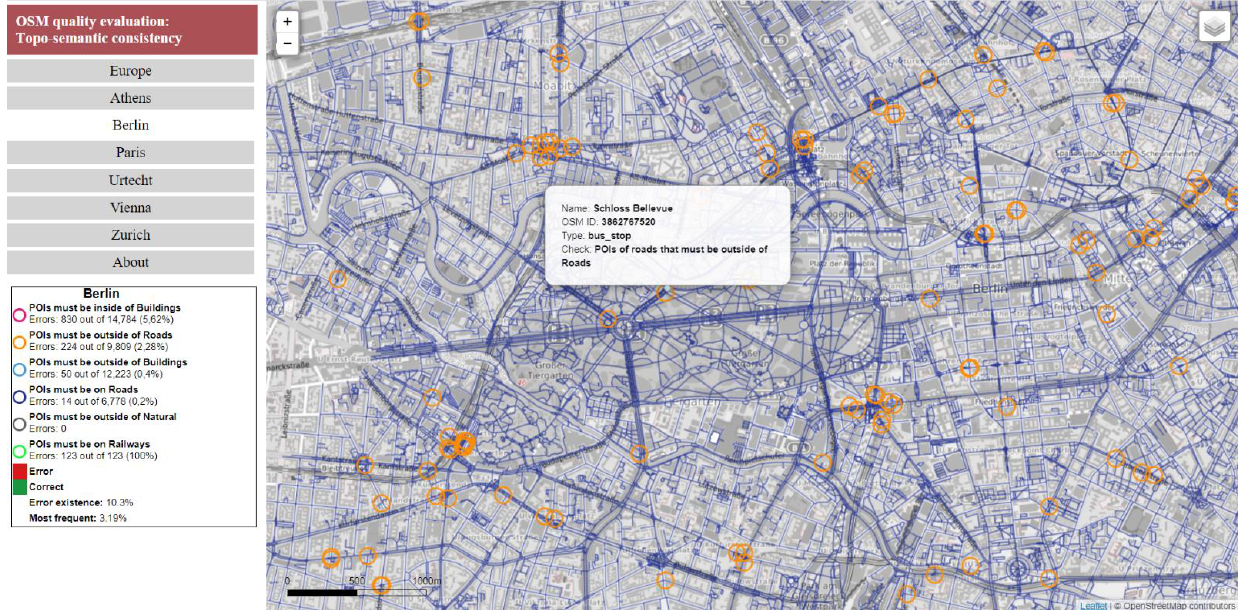
Figure A11. Errors from the topo-semantic consistency check “POIs must be outside of Roads” for Berlin are portrayed on the BW OSM basemap. The “Roads” layer is portrayed as well. Additional information is provided by clicking on each error.